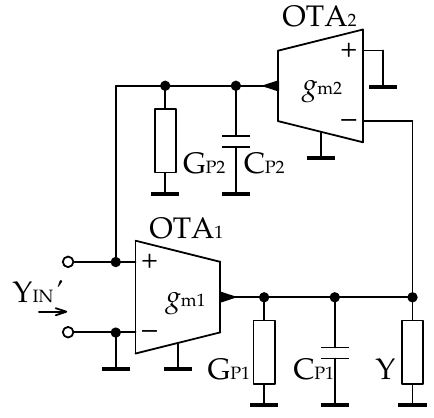
Figure 3. Gyrator with OTA parasitic properties.